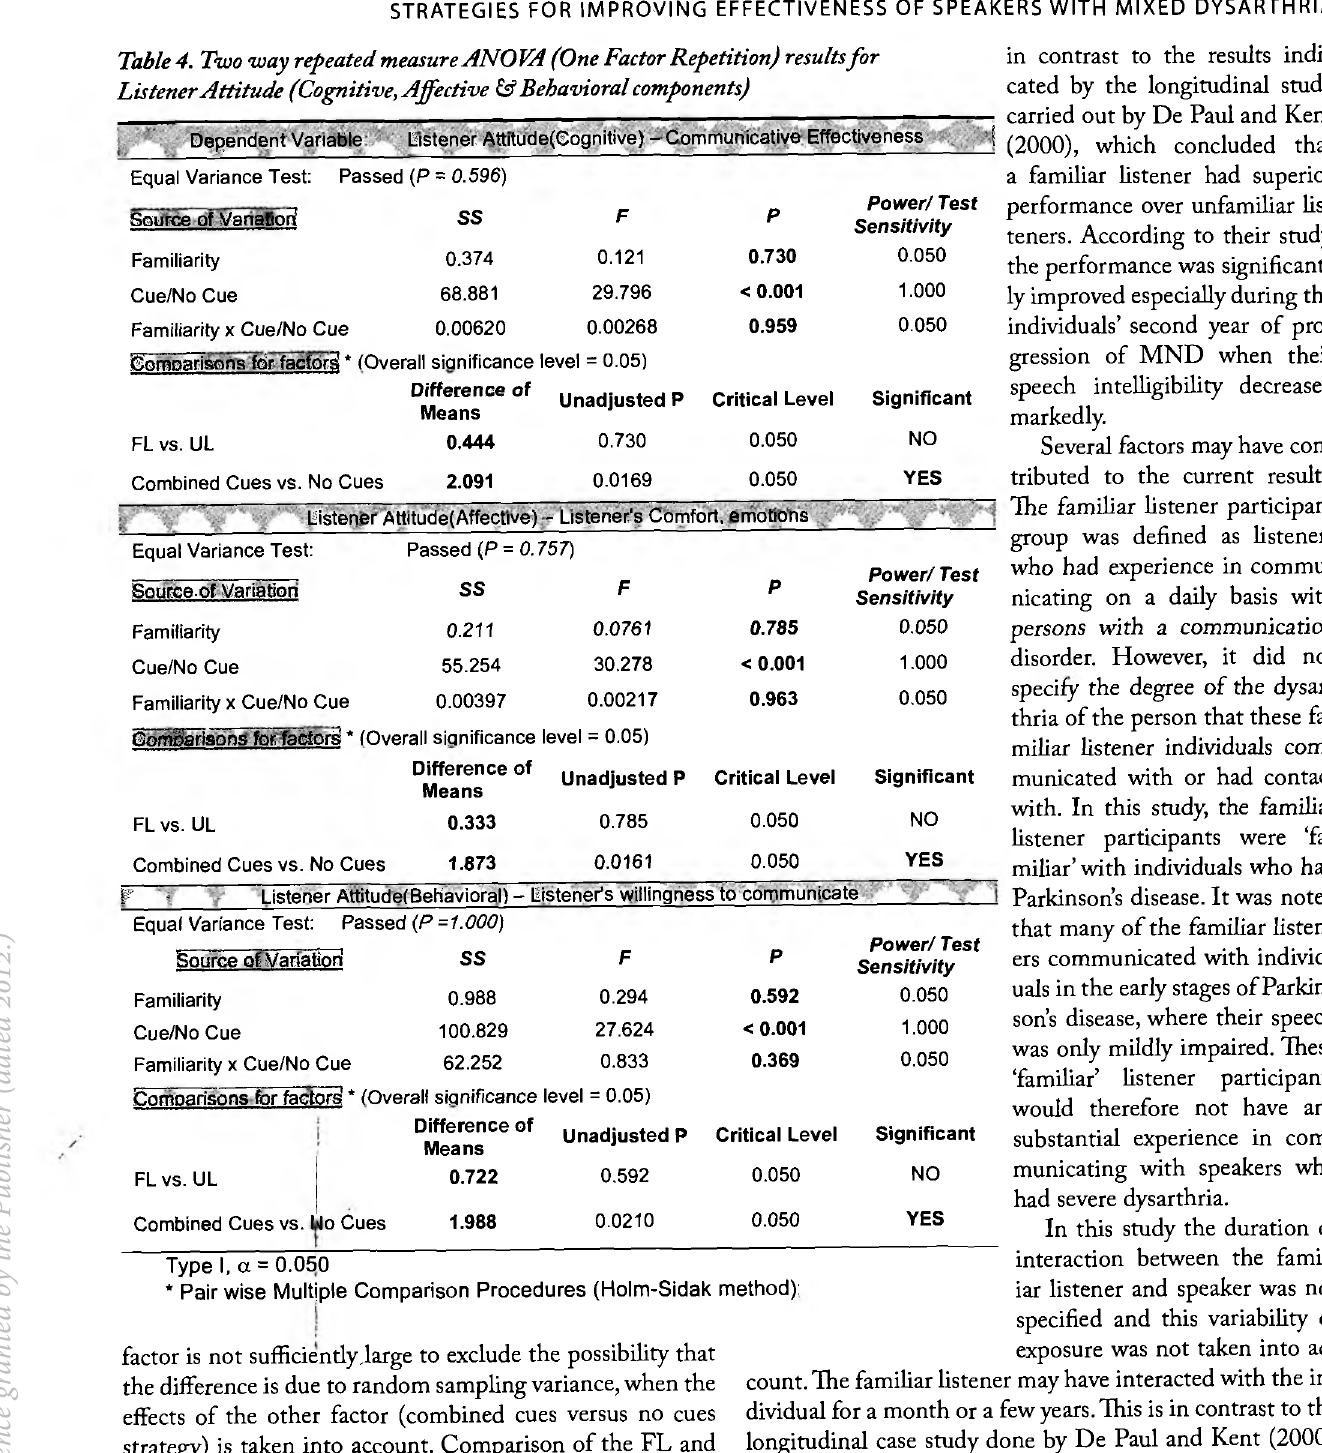
Table 4. Two way repeated measure ANO VA (One Factor Repetition) results for Listener Attitude (Cognitive, Affective & Behavioral